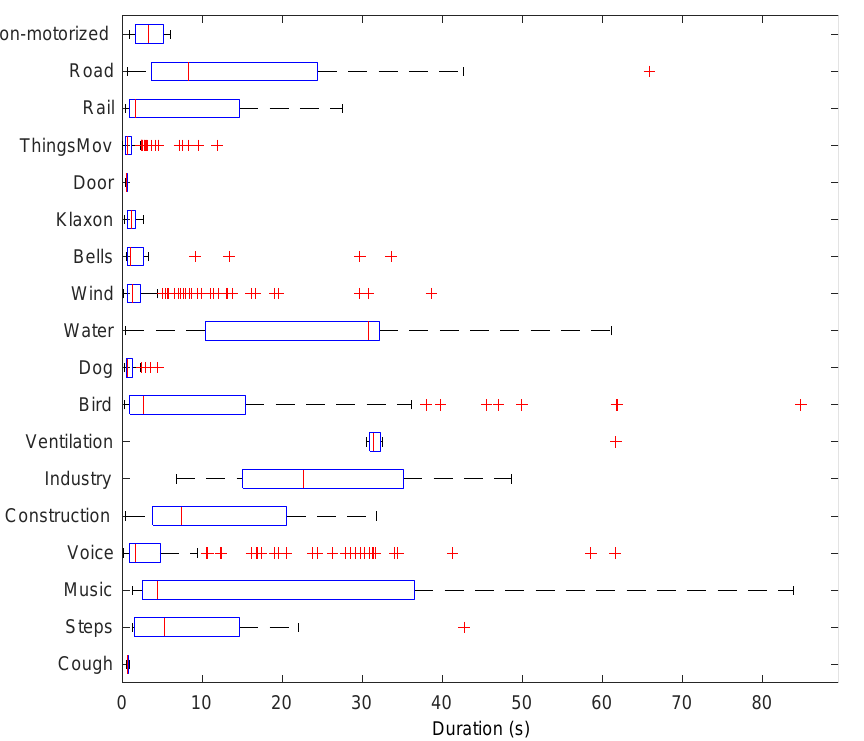
Figure 5. Duration of the different sound elements in the 2021 Sons al Balcó